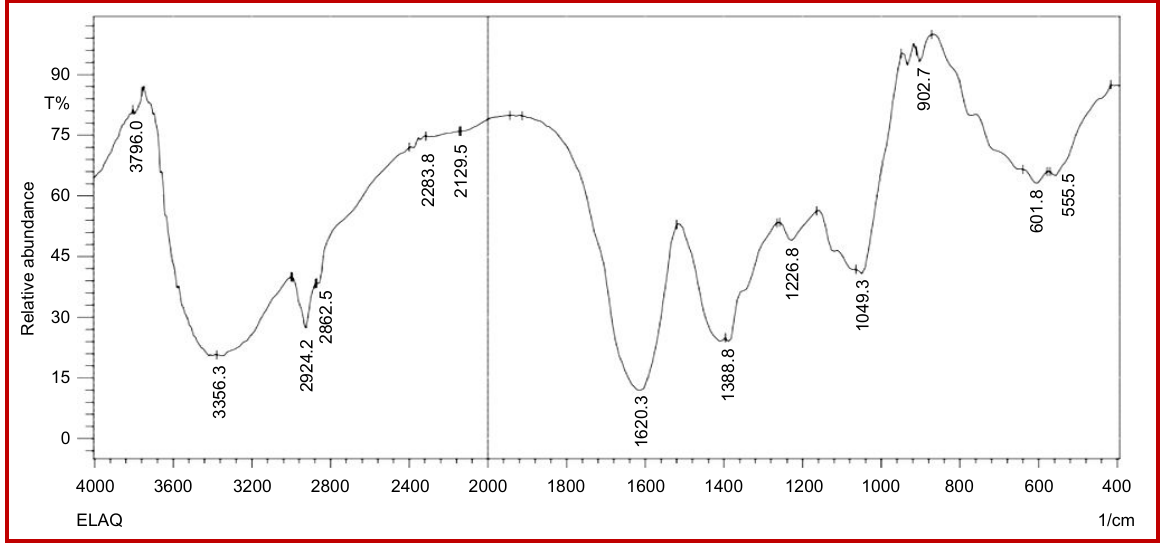
Figure 2: FTIR chromatogram of ethanolic leaf extract of E.